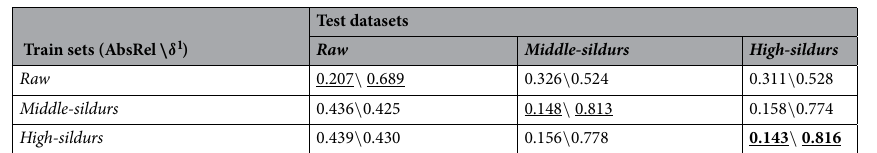
Table 4. The performance of the accuracy of the generated dataset under different rendering shaders. Here AbsRel and δ < 1.25 1 are used as error and accuracy indicators. The best result in each row has been underlined and the optimal result has been